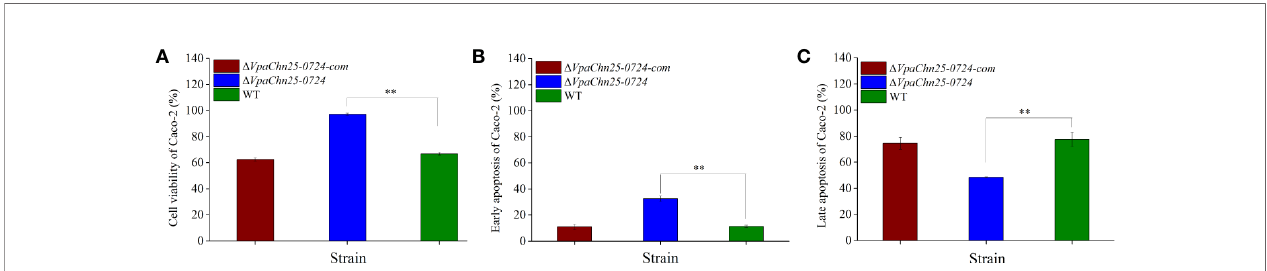
FIGURE 7 | The viability and apoptosis of Caco-2 cells infected by V. parahaemolyticus CHN25 (WT), D VpaChn25_0724 , and D VpaChn25_0724-com strains. The infection was performed at 37°C for 4 h. (A) Cell viability; (B) Early stage of apoptosis; (C) Late stage of apoptosis. **p<0.01 compared with the